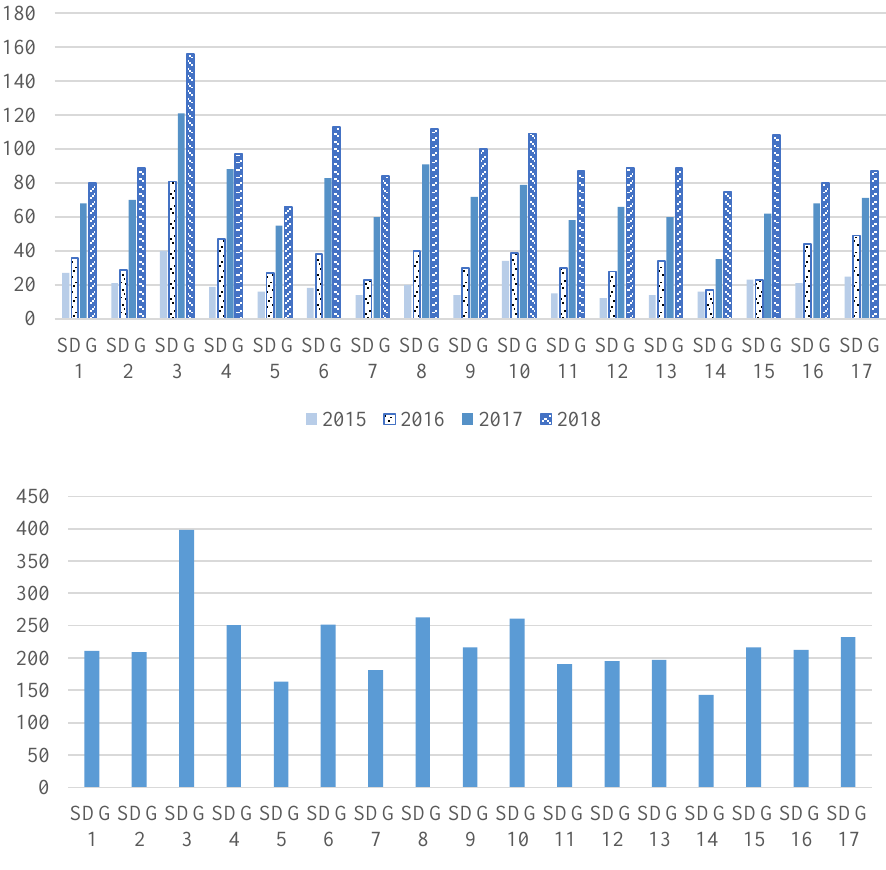
Figure 2. The number of academic references for each SDG in each year (upper) and the sum from 2015 to 2018 (lower).